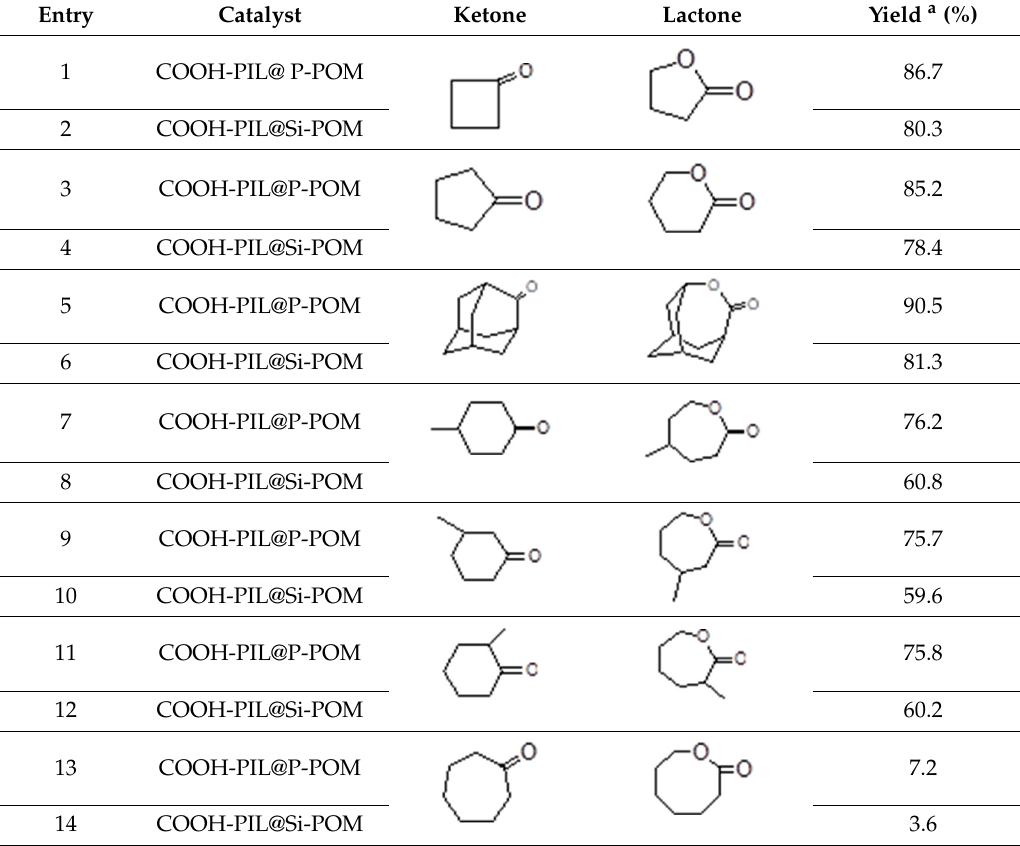
Table 2. Results of BV oxidation of various cyclic ketones with H 2 O 2 catalyzed by two ionic self-assemblies.